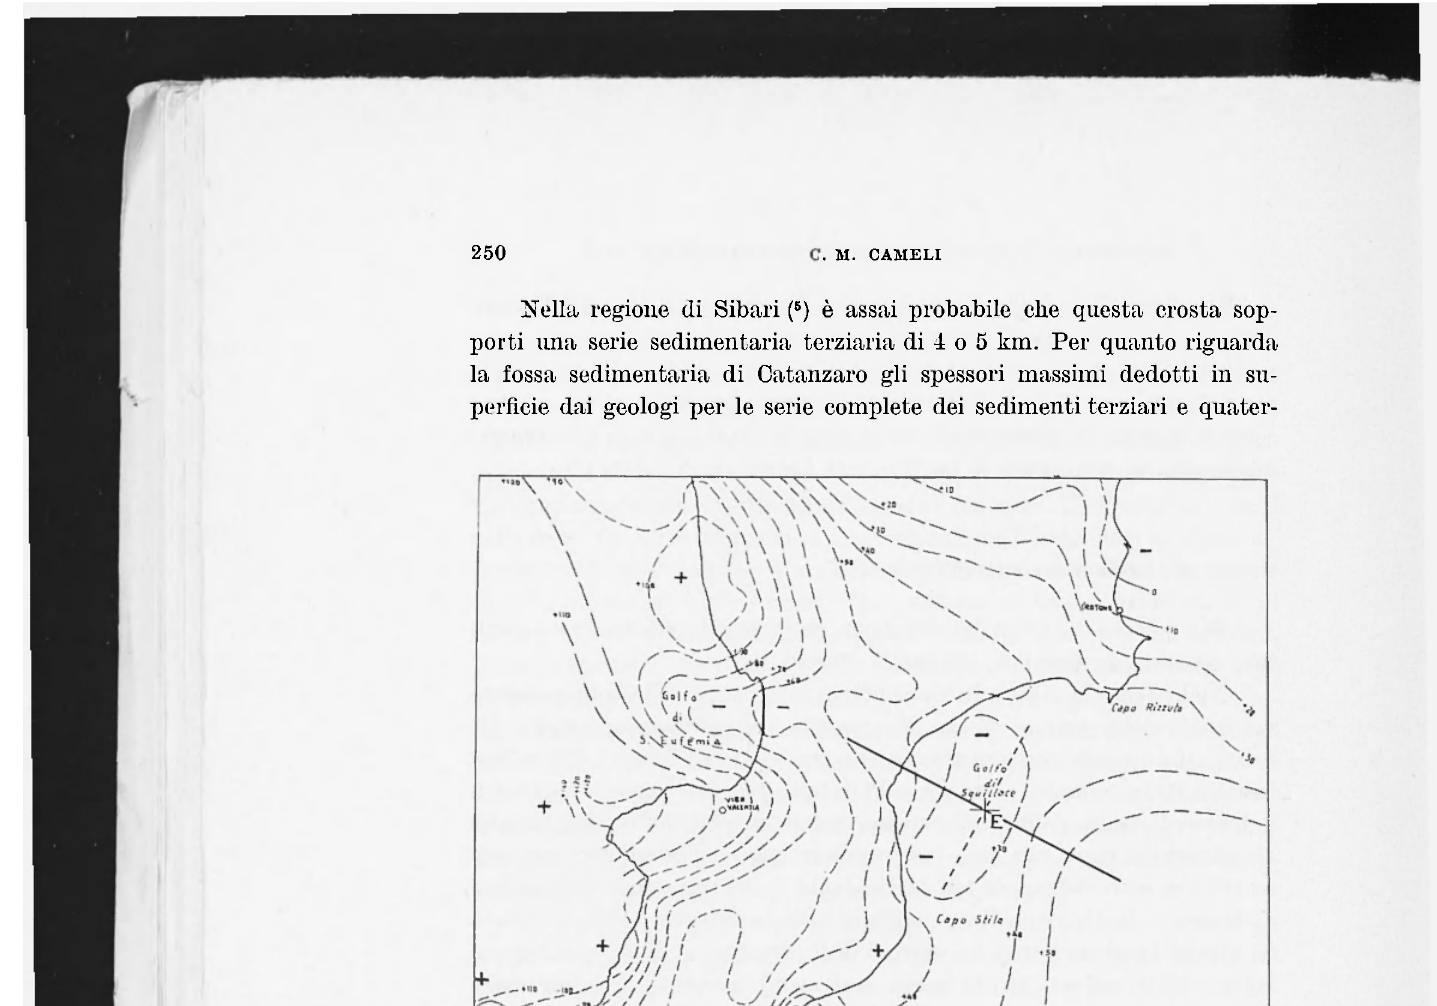
Fig. 3 - Carta gravimetrica della Calabria e piano di frattura del terremoto del golfo di